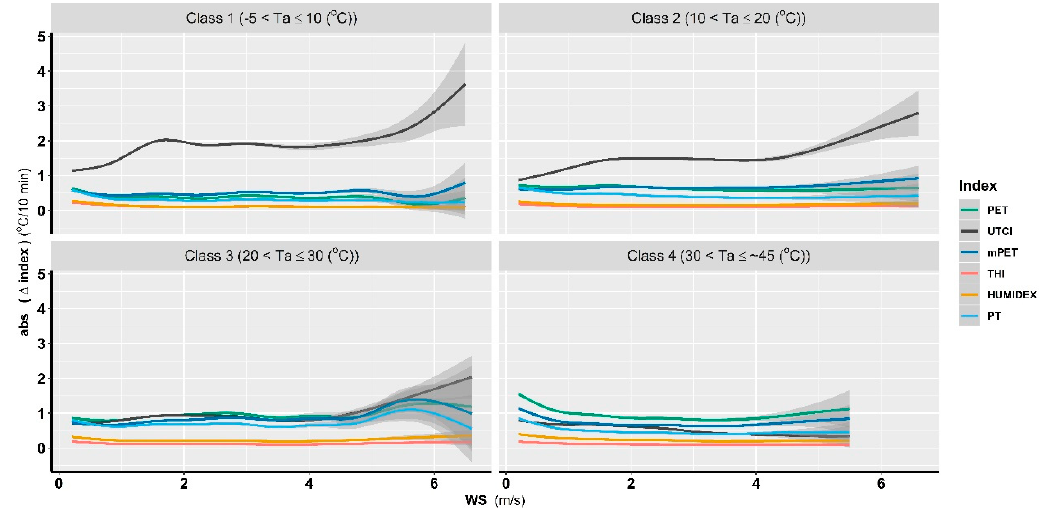
Figure 8. The sensitivity of the indices to wind speed (WS) variation under different air temperature (T a ) conditions.